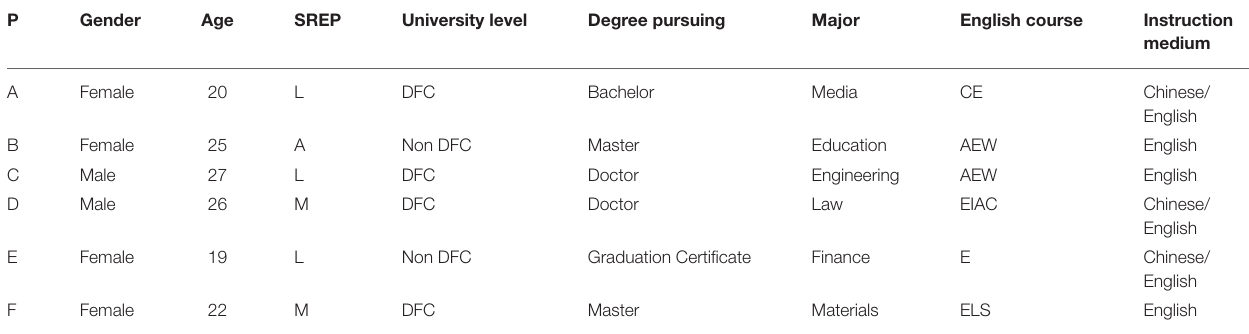
TABLE 2 | Description of participants.